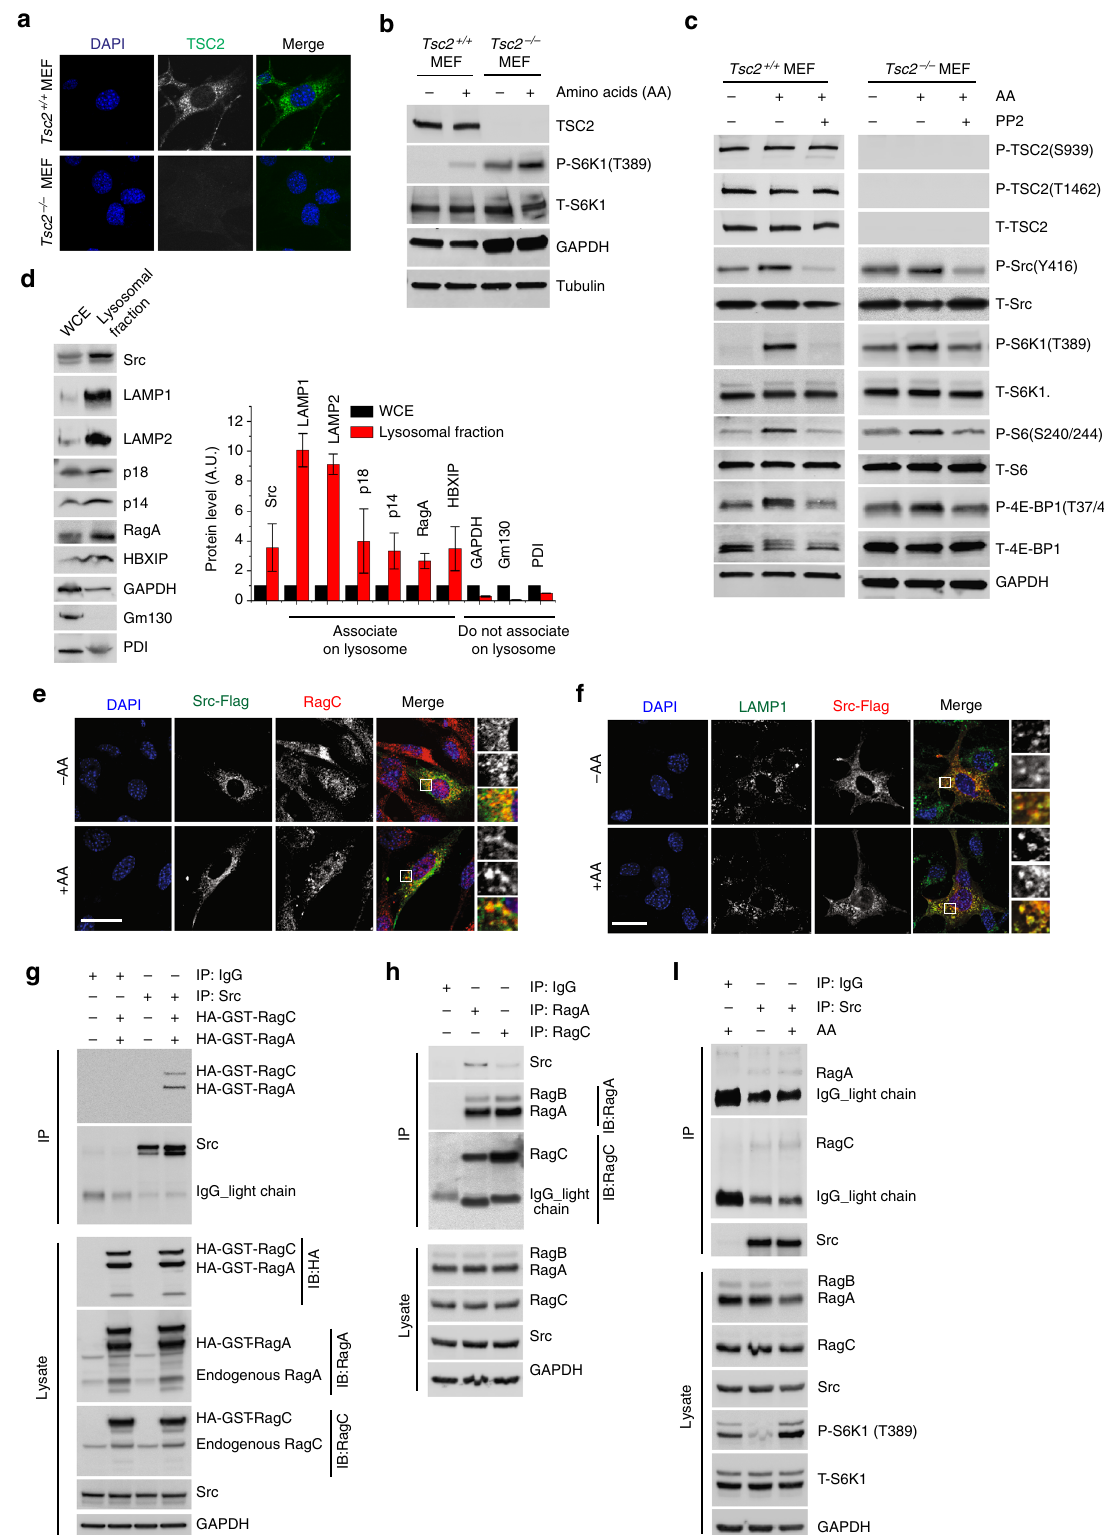
Rag – mTORC1 signaling by dissociating GATOR1 from Rag pro- teins. Expression of constitutively active Src (CA-Src) dramatically reduced GATOR1 – Rag interaction (Fig. 4c); as a consequence, a strong activation of mTORC1 was observed. Importantly,